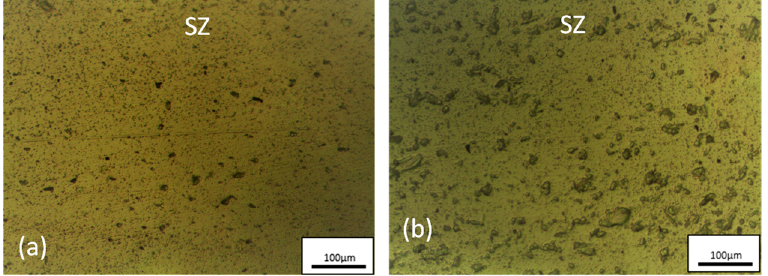
Figure 26. Microscopy image of, ( a ) SZ at 1150 rpm, 30 mm/min and ( b ) SZ at 1200 rpm, 20 mm/min.